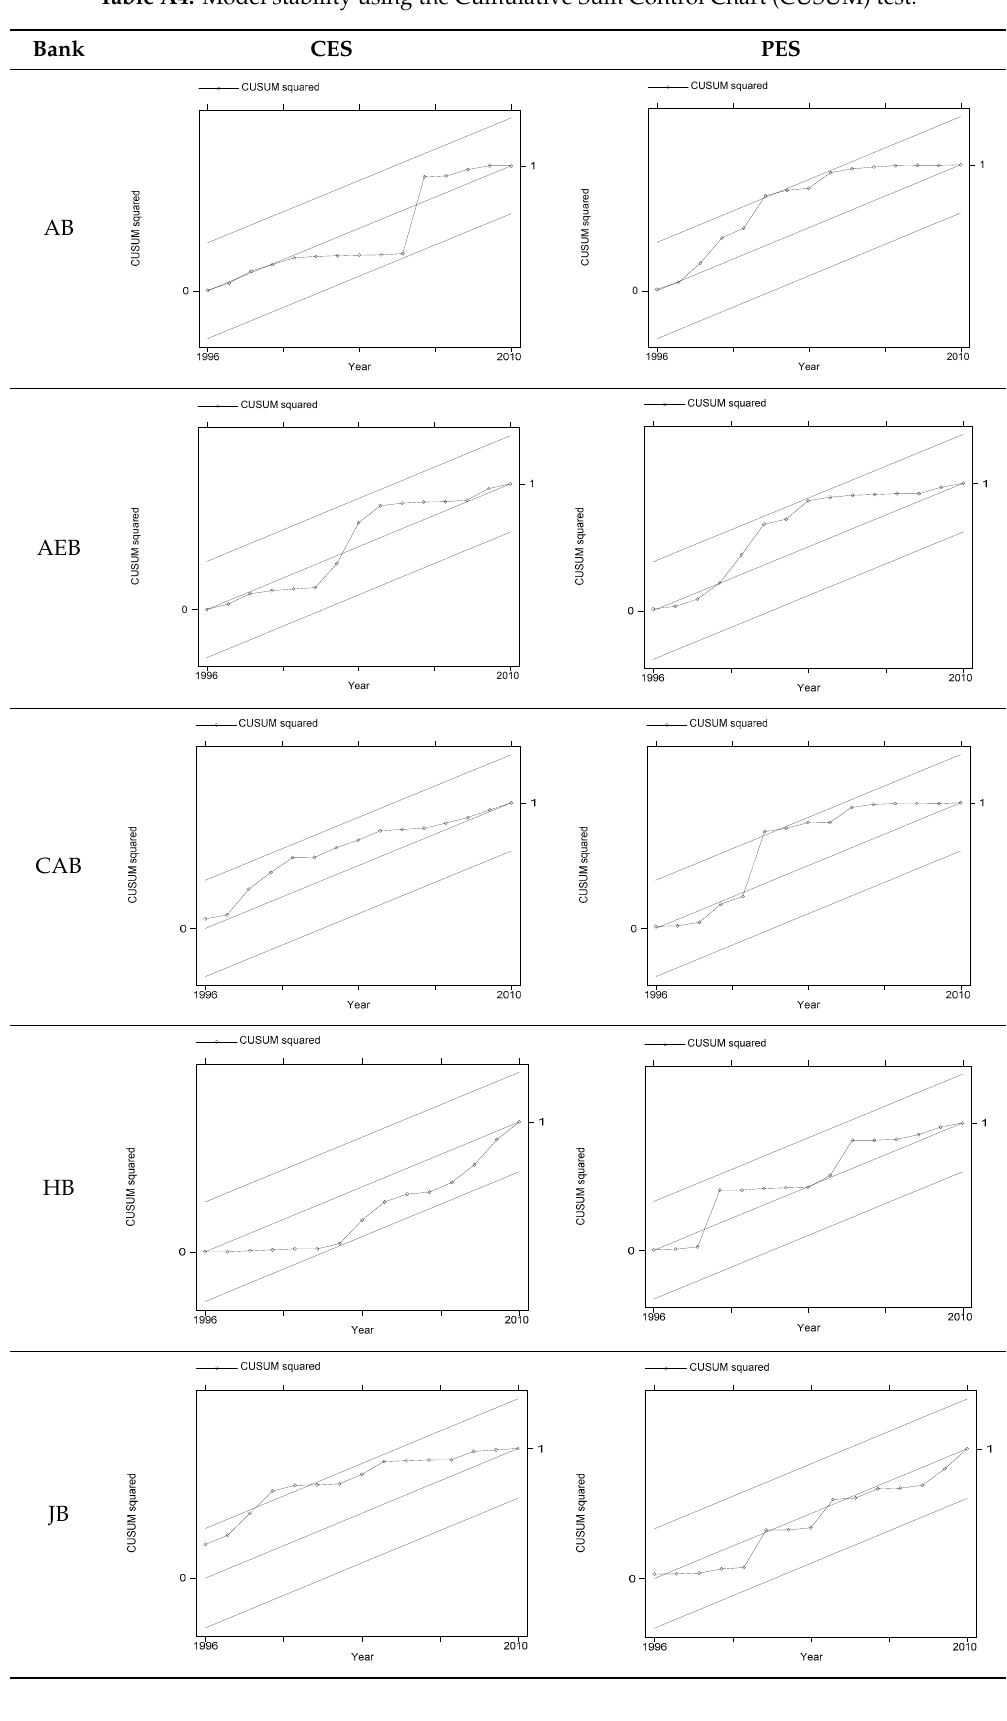
Table A4. Model stability using the Cumulative Sum Control Chart (CUSUM) test.